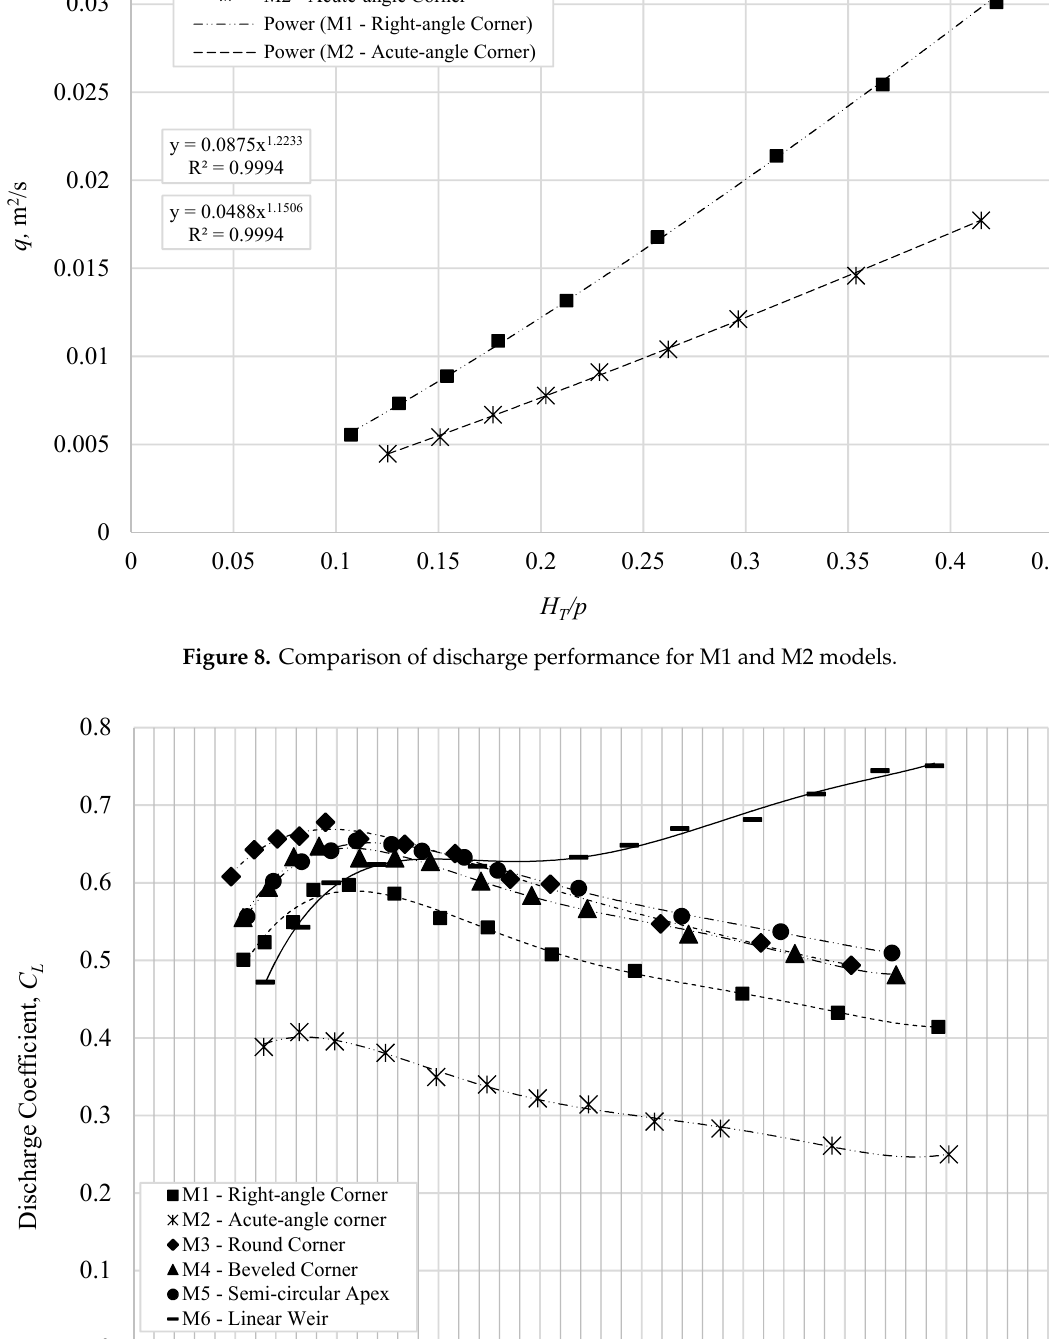
y = 0.0875x 1.2233 R² = 0.9994